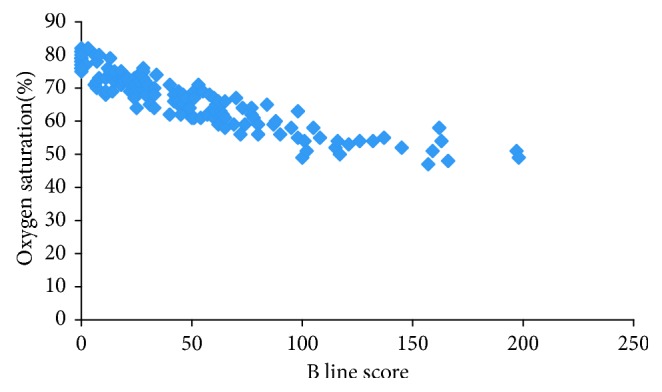
Distribution of oxygen saturation and B-line score in all participants (adjusted R2 for B-line score vs. oxygen saturation = 0.819; P=0.000). A scatterplot graph generated by Excel 2016 was provided to describe the relationship between B-line score and oxygen saturation.